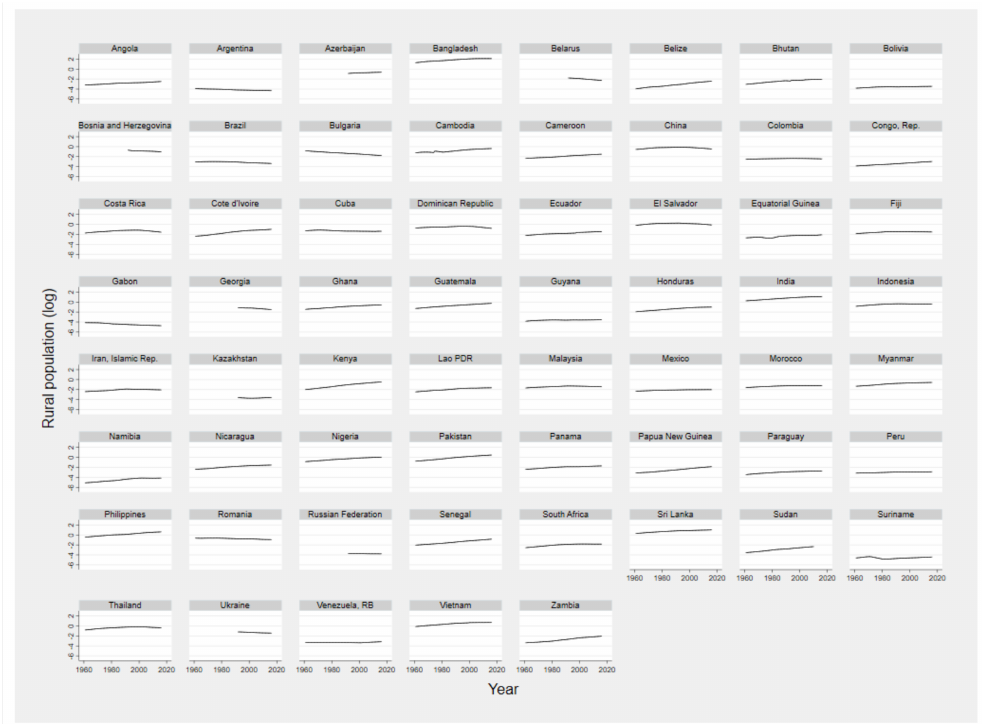
Figure A13. Temporal evolution of rural population density, middle-income group.